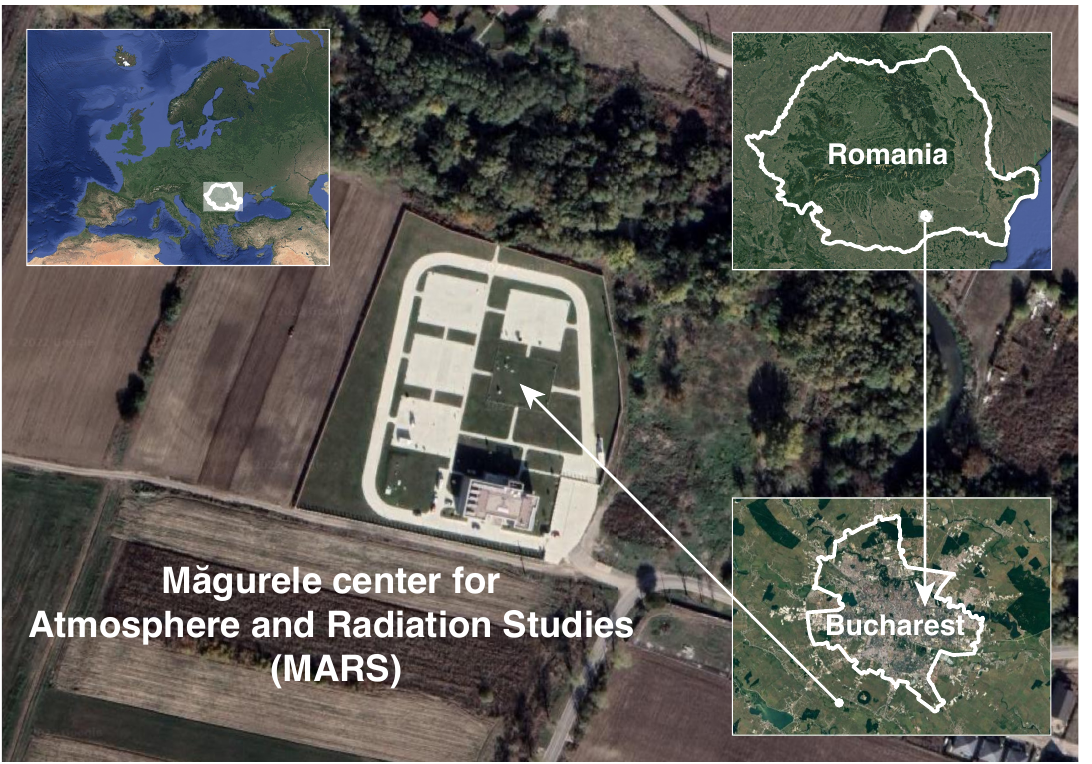
Figure 1. The location of the M˘agurele centre for Atmosphere and Radiation studies (MARS) with respect to Bucharest. Based on Google Maps (map data: Google, Maxar Technologies) processed on QGIS